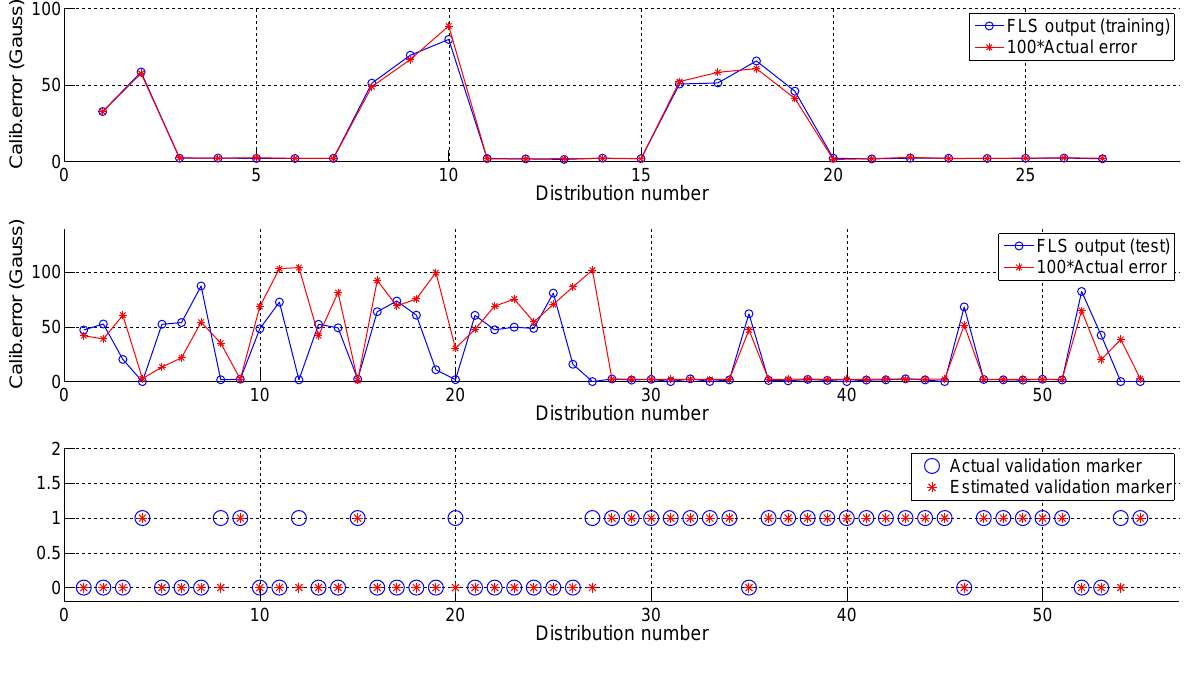
FLS training using dataset 1 ( top ), test using dataset 2 ( center ) and final validation ( bottom ).